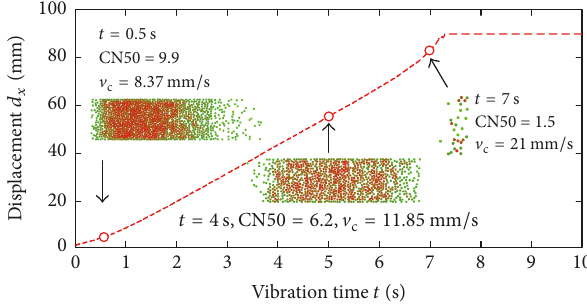
Figure 15: Particles average displacement in the 𝑥 -direction throughout the simulation and the variation of the CN distribution and V c at various time points ( 𝑡 = 0.5 s, 𝑡 = 4 s, and 𝑡 = 7 s).